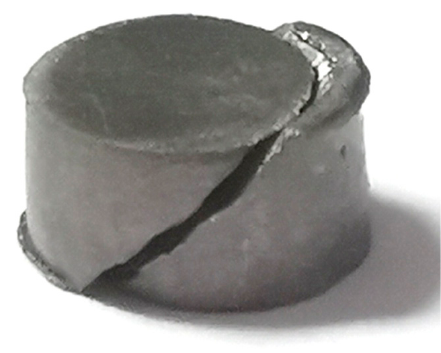
Figure 14. Macroscopic damage profile of compressed specimens.